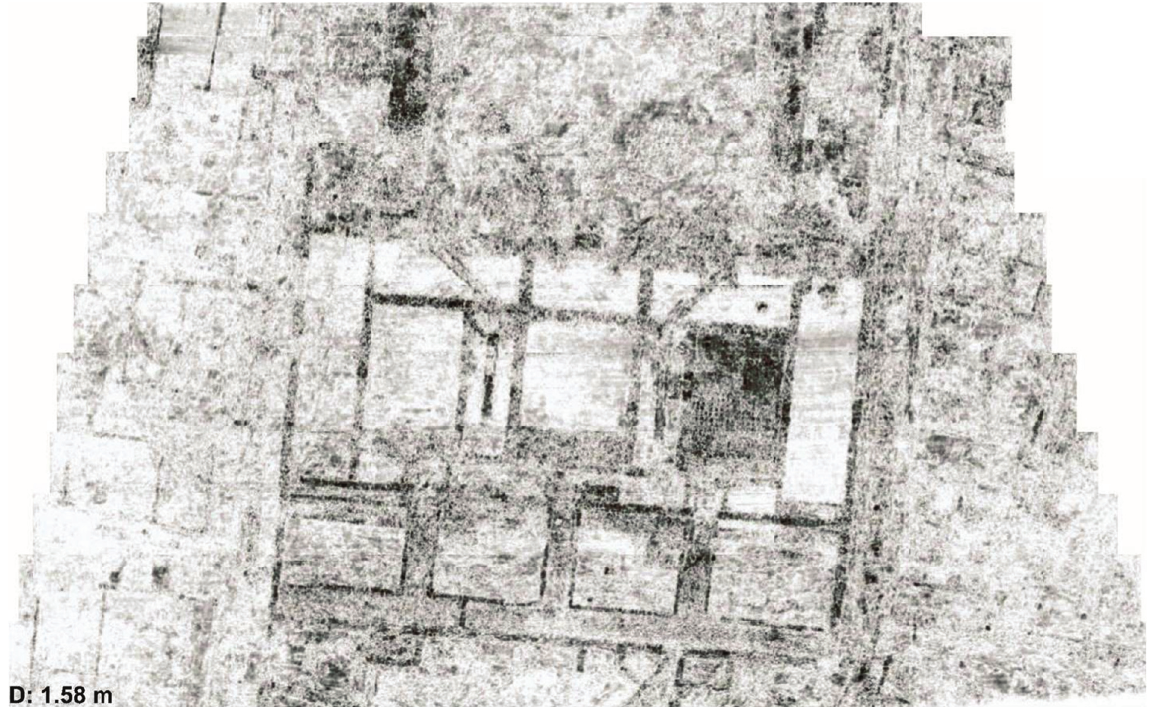
Figure 5. The GPR depth-sl system